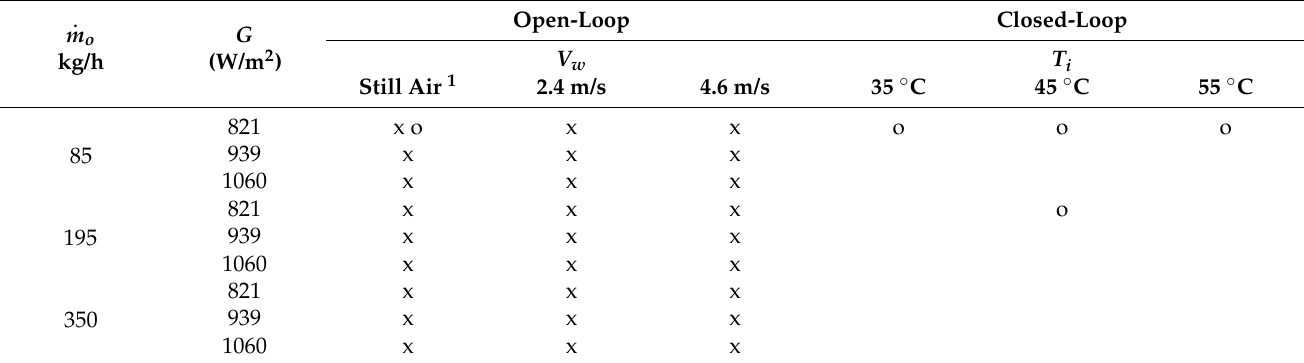
Table 4. Test conditions for the indoor steady-state performance characterization.